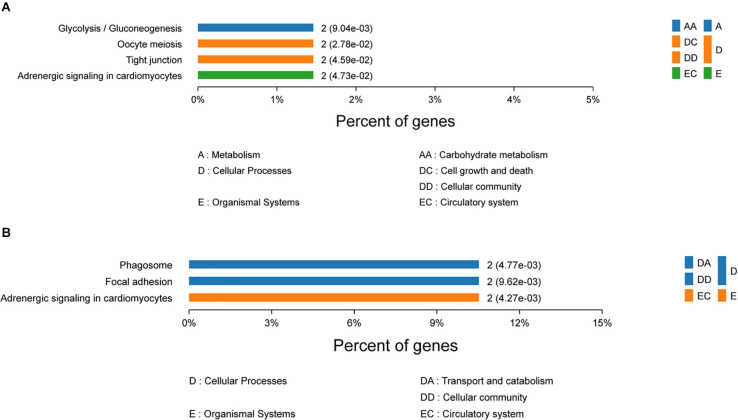
KEGG pathway enrichment analysis of differentially expressed proteins in 120 d vs 90 d (A) and 150 d vs 120 d (B).